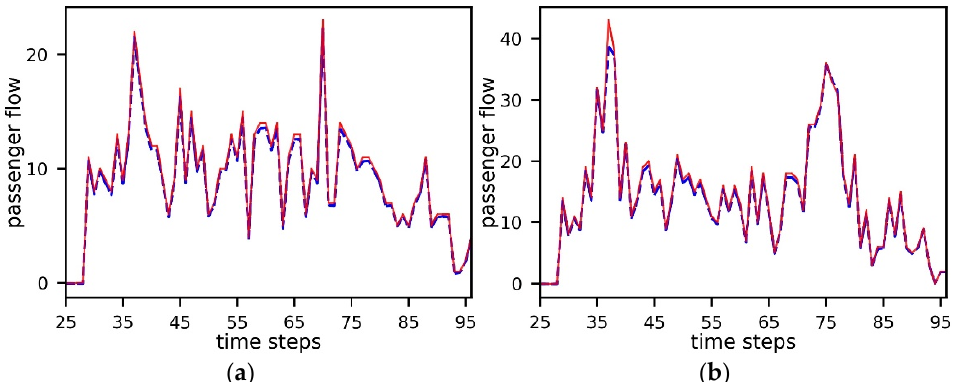
Figure 7. The examples of forecasting curves and the ground-truth curves for OD 1: ( a ) weekdays; ( b ) weekends.